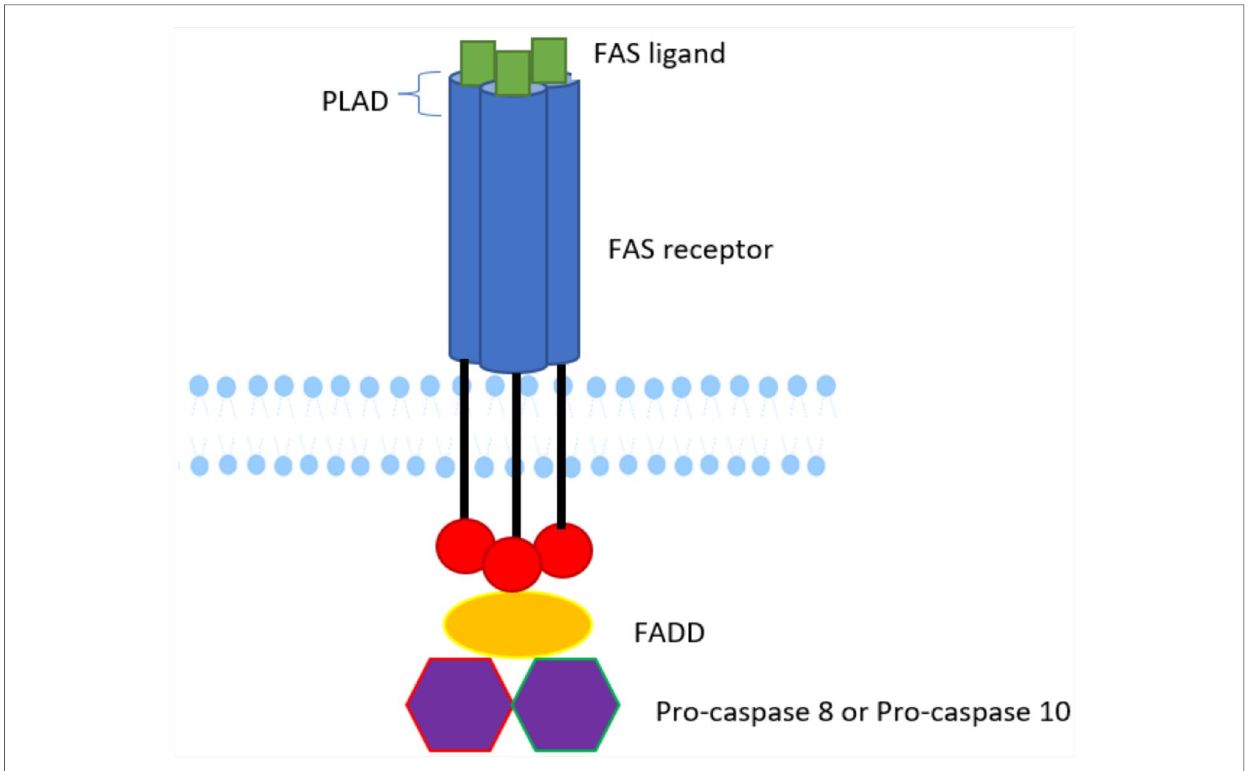
FIGURE 3 Schematic diagram of FAS protein. The structure of FAS protein is indicated. The pathogenic variant affects the death domain, consequently affecting the signal transduction pathway, which would normally involve recruitment of FADD and activation of pro-caspase 8 or 10. Diagram courtesy of Khadija